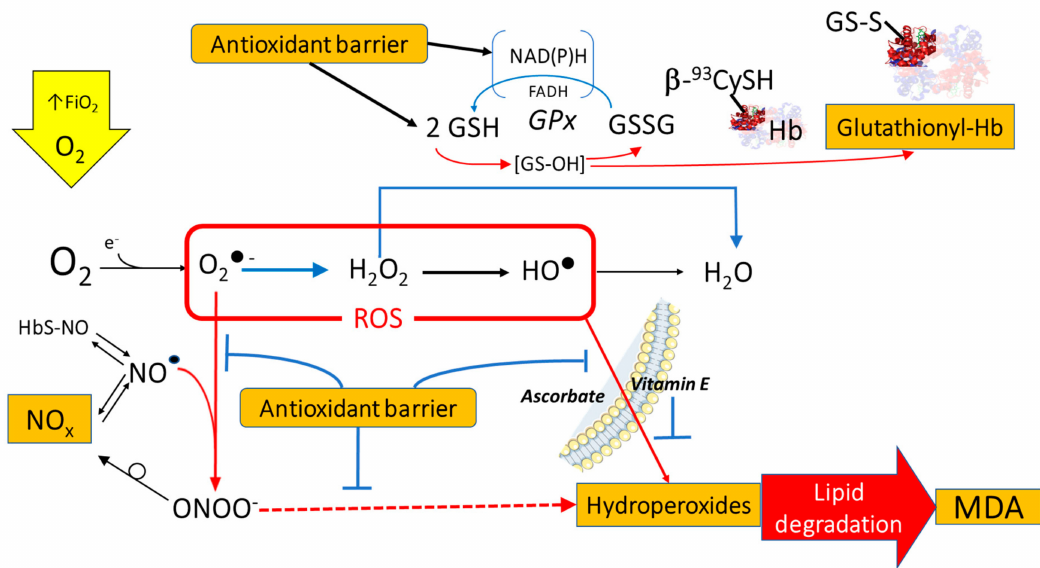
Figure 5. Some mechanisms for the production of the main Reactive Oxygen Species (ROS) from excess dissolved molecular oxygen (O 2 ) and the biomarkers used to evaluate its e ff ects. Orange squares: oxidative stress markers considered in this study. Blue arrows: reduction processes. Red arrows: oxidation